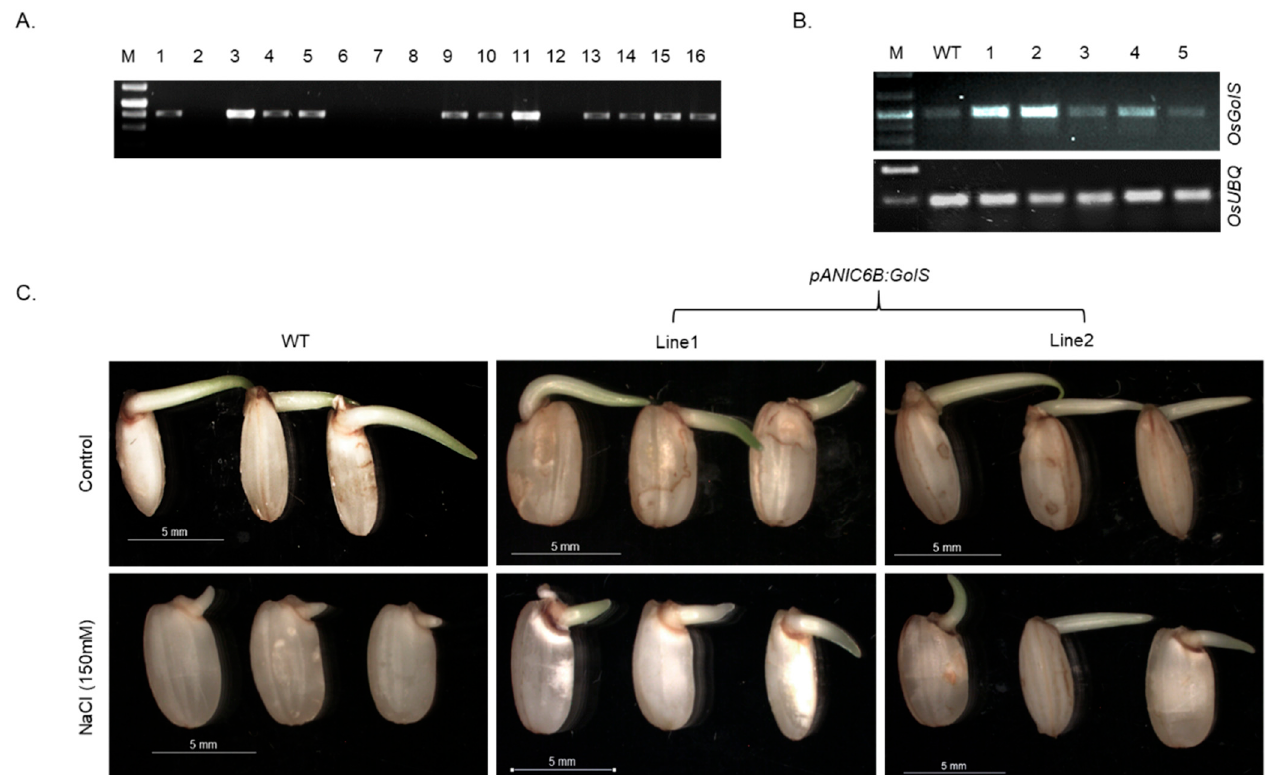
Figure 3 . Molecular analysis of OsGolS overexpression lines. ( A ) Screening of positive transformation events via amplification of the hptII gene from the genomic DNA of putative transformants. ( B ) Semi-quantitative RT-PCR analysis of selected positive transformants for OsGolS and the rice ubiquitin ( OsUBQ) gene, WT; wild-type plant. ( C ) Germination test of WT and transgenic lines (OE-1 and OE-2) under salinity stress.